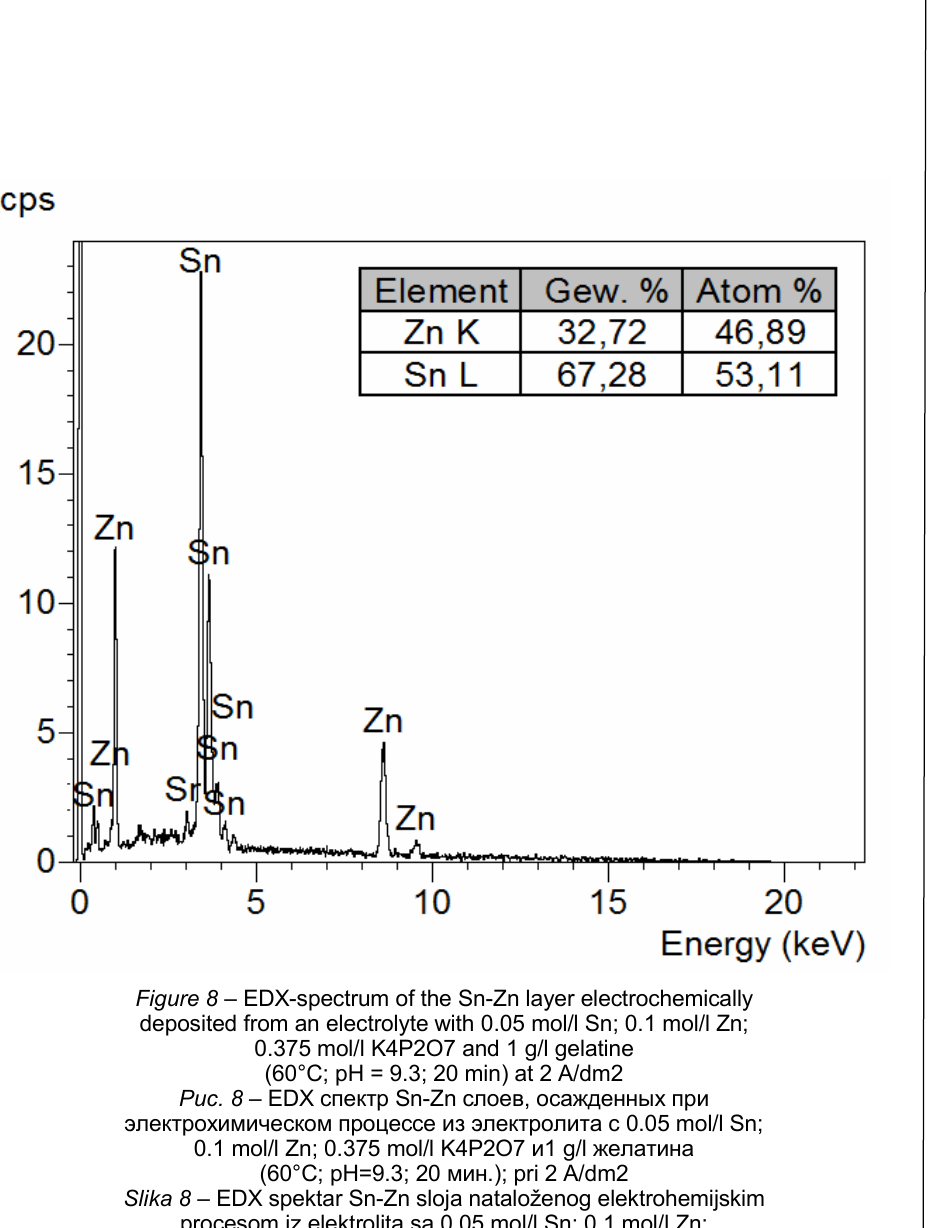
Figure 8 – EDX-spectrum of the Sn-Zn layer electrochemically deposited from an electrolyte with 0.05 mol/l Sn; 0.1 mol/l Zn; 0.375 mol/l K4P2O7 and 1 g/l gelatine (60°C; pH = 9.3; 20 min) at 2 A/dm2 Рис . 8 – EDX спектр Sn-Zn слоев , осажденных при электрохимическом процессе из электролита с 0.05 mol/l Sn; 0.1 mol/l Zn; 0.375 mol/l K4P2O7 и 1 g/l желатина (60°C; pH=9.3; 20 мин .); pri 2 A/dm2 Slika 8 – EDX spektar Sn-Zn sloja nataloženog elektrohemijskim procesom iz elektrolita sa 0.05 mol/l Sn; 0.1 mol/l Zn; 0.375 mol/l K4P2O7 i 1 g/l želatina (60°C; pH = 9.3; 20 min) pri 2